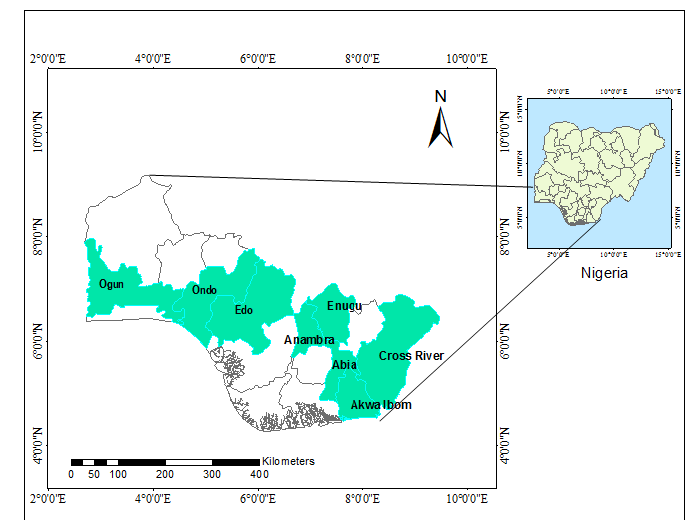
Fig. 1. Map of Southern Nigeria showing distribution of D.